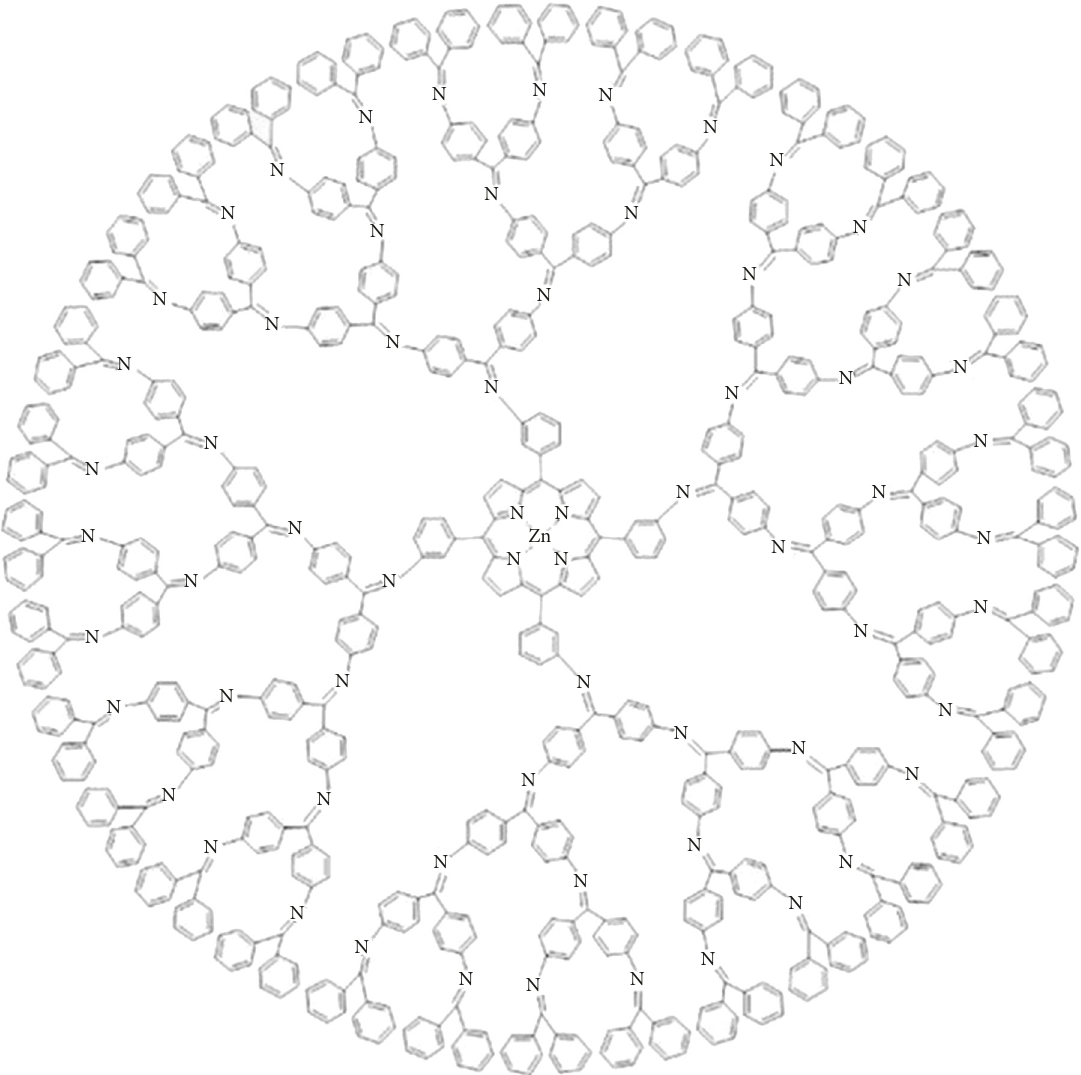
Figure 10: Zinc-porphyrin dendrimer (DPZ